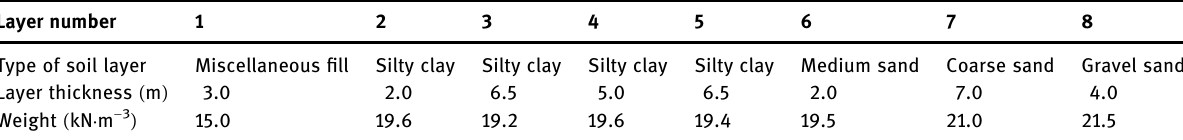
Table 4: Composition of the soil layers Layer